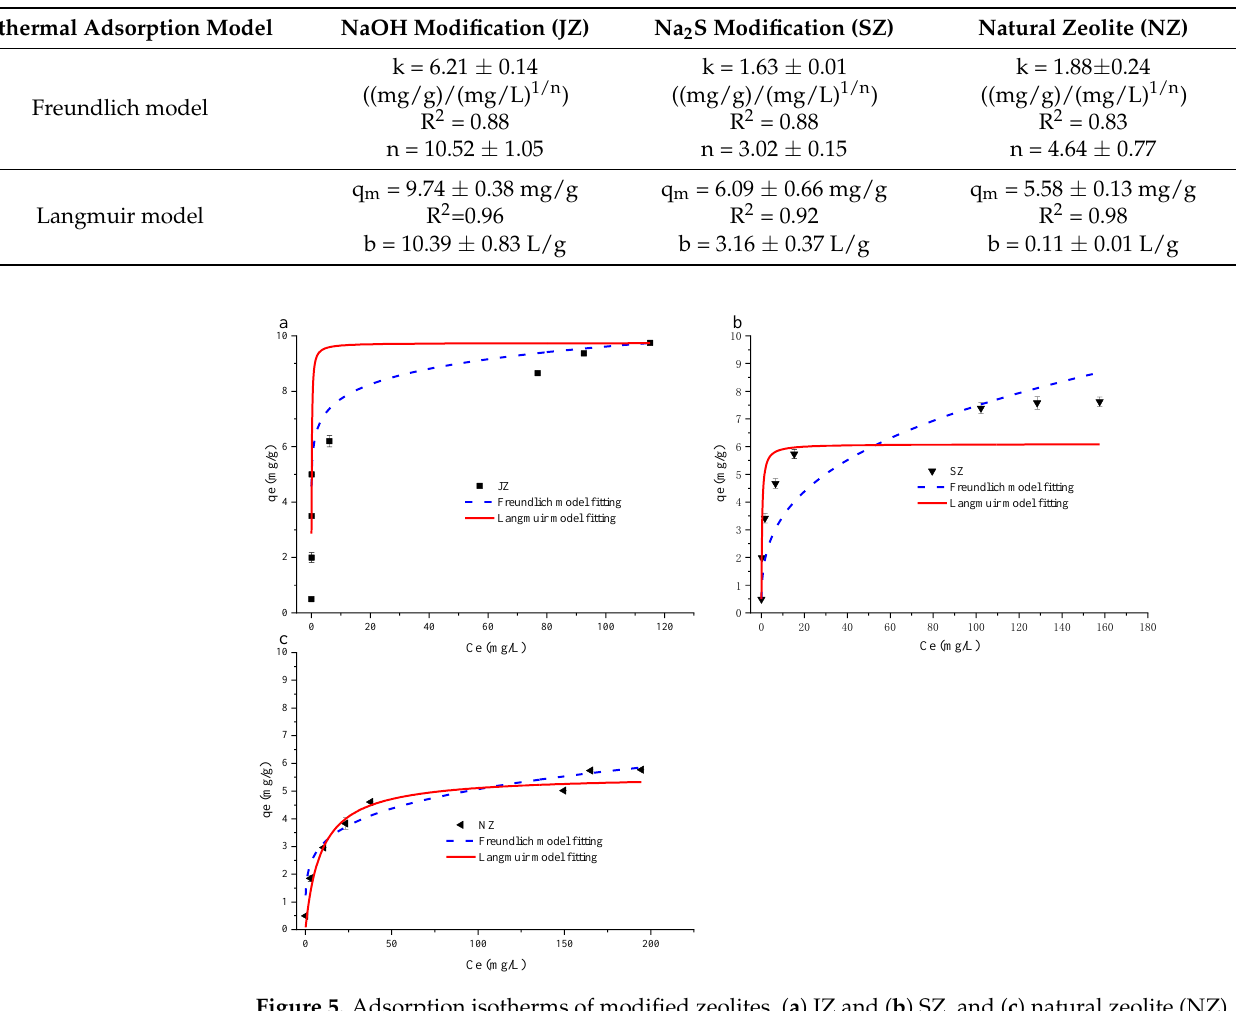
Figure 5. Adsorption isotherms of modified zeolites, ( a ) JZ and ( b ) SZ, and ( c ) natural zeolite (NZ).